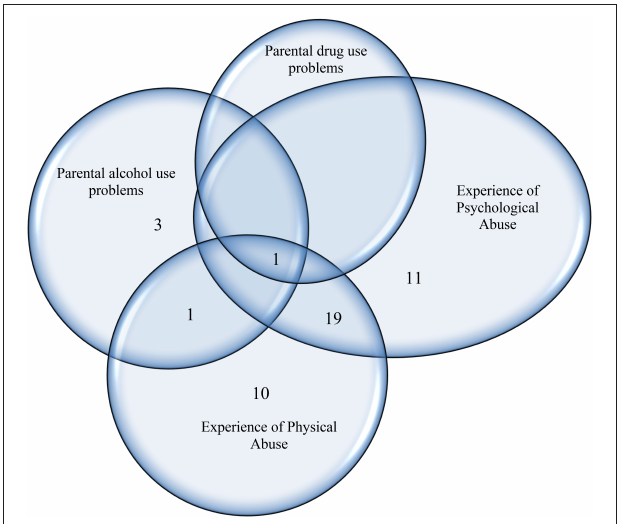
FIGURE 2 | The prevalence of male students reporting the existence of different negative psychosocial problems in a sample of Swedish high school students ( n = 111).